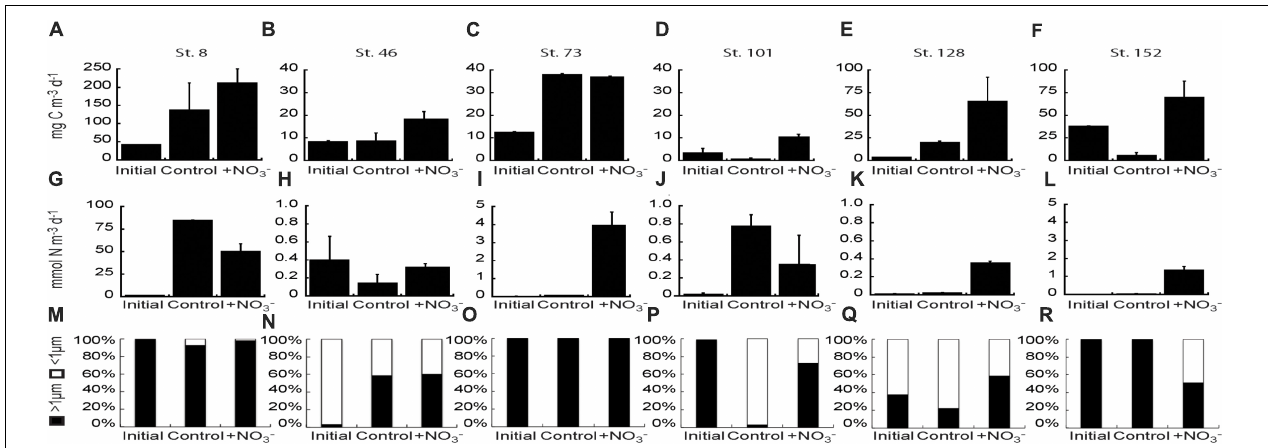
FIGURE 7 | Carbon fixation rate (A–F) and NO 3 − uptake rates (G–L) of the bulk phytoplankton and microbial community at initial and final (Control and +NO 3 − ) time points in the